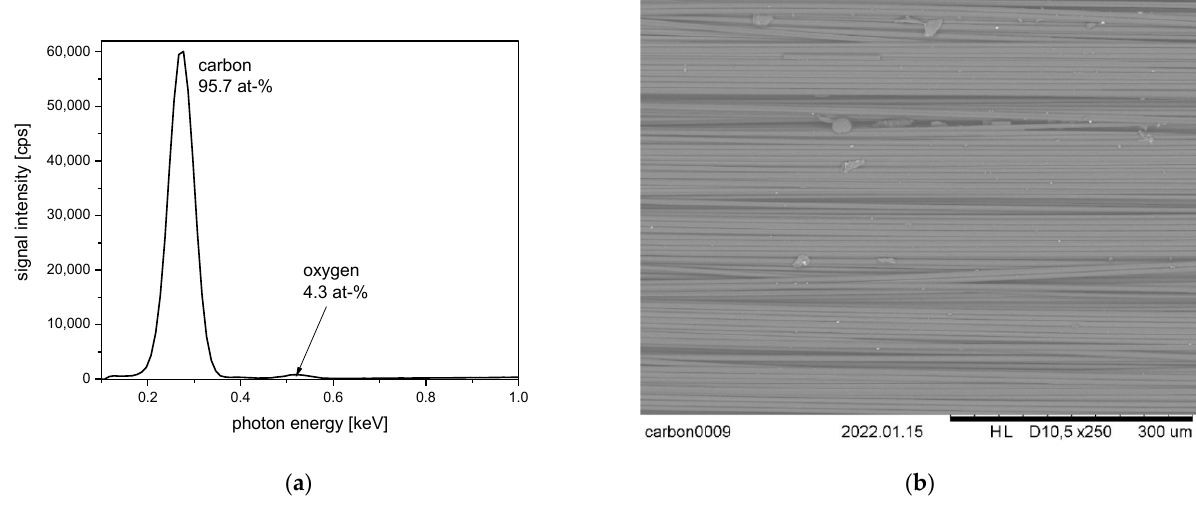
Figure 32. Carbon fibers from fabric (Sigratex Fabric KDK)—( a ) EDS spectrum; ( b ) SEM image.